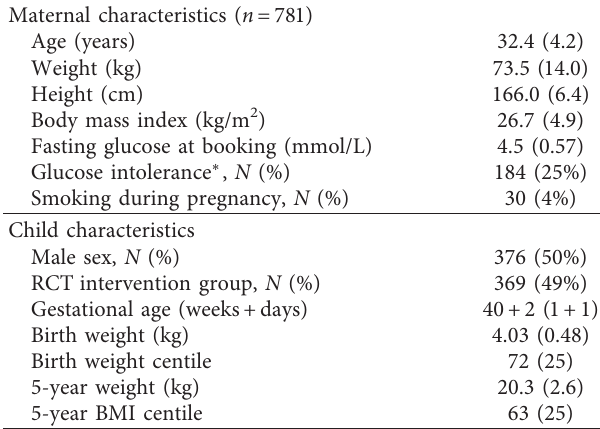
Table 1: ROLO Demographics—baseline characteristics of total